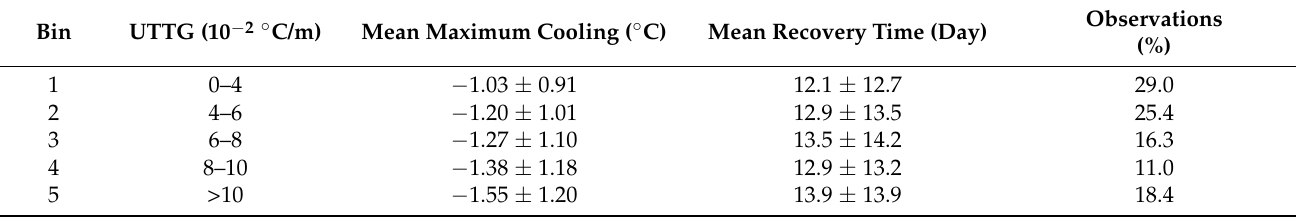
Figure 5. ( a ) Mean maximum cooling ( ◦ C) on each day in different MLD bins and ( b ) the average and standard deviation of maximum cooling ( ◦ C) and recovery time (days) in different MLD bins. D0 denotes the day of TC passage. The thin and bold error bars represent the standard deviation of the individual value and the mean, respectively. The standard deviation of the mean is multiplied by 10 in the plot. Table 2. The average and standard deviation of maximum cooling and recovery time and observational frequency distributions (%) for different UTTG